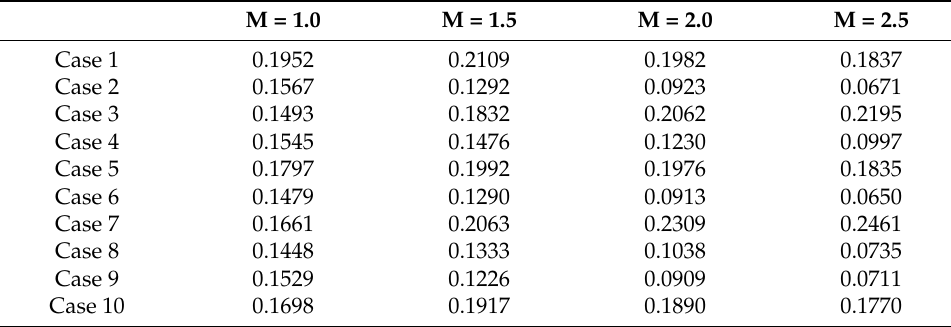
Table 2. Overall averaged FCE for 13 cases (DR = 2.0).